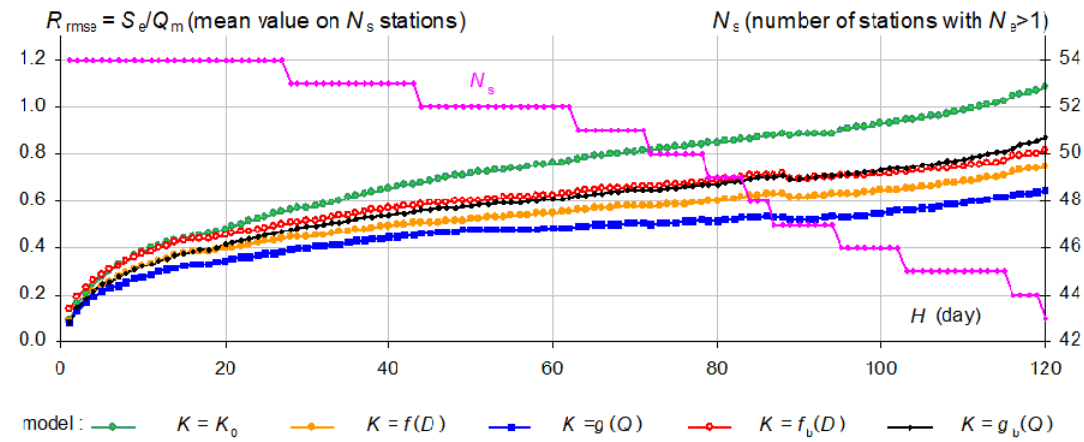
Figure 12. Average model performance in forecasting discharge at all stations, according to the forecast horizon H (average of the relative standard error R rmse , calculated on the N s stations for which the number N e of discharge forecasts at horizon H is greater than 1).